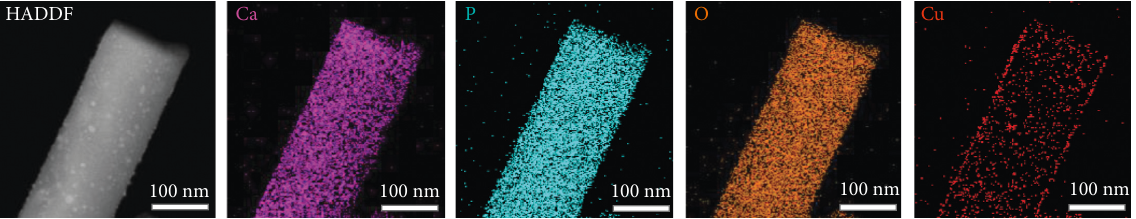
Figure 6: HADDF-STEM image and EDX elemental mappings of hydroxyapatite after adsorbing